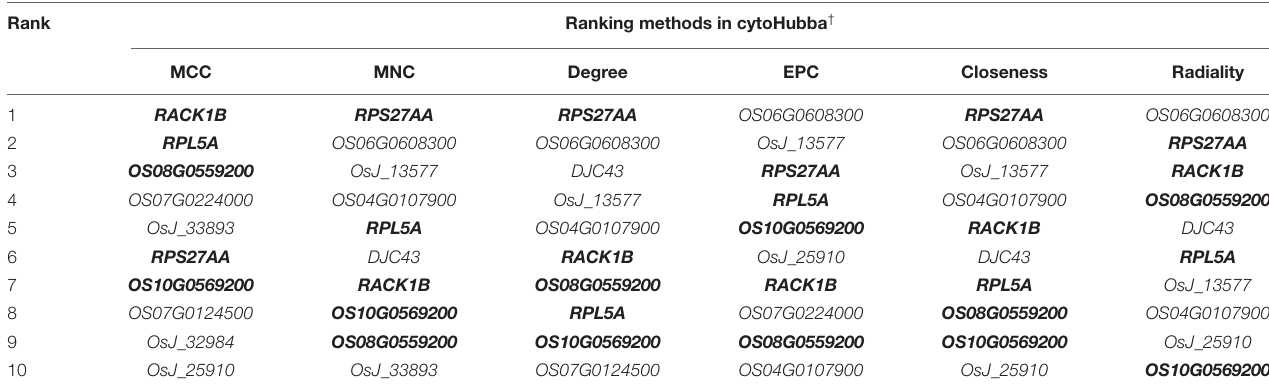
† Genes indicated in bold represent hub genes identified within the top 10 list by each of the six ranking methods in cytoHubba. MCC, maximal clique centrality; MNC, maximum neighborhood component; Degree, node connect degree; EPC, edge percolated component; Closeness, closeness centrality; Radiality, reachability to other